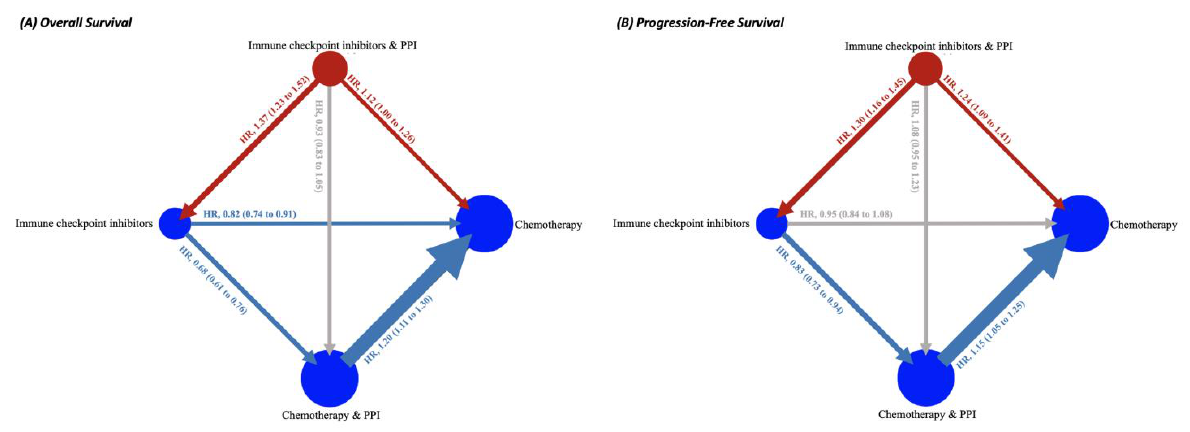
Figure 2. Network plot for comparative association among PPI, ICI, and chemotherapy in terms of ( A ) overall survival and ( B ) progression-free survival. The thickness of the connecting line corresponds to the number of trials among comparators. We specifically highlight the arm ICI with baseline PPI as red node, the red arrow as its significant comparison with ICI, and chemotherapy without baseline PPI to reiterate our main findings. Blue arrows also indicate significant survival association between two nodes. Conversely, gray arrows suggest little association between two arms.